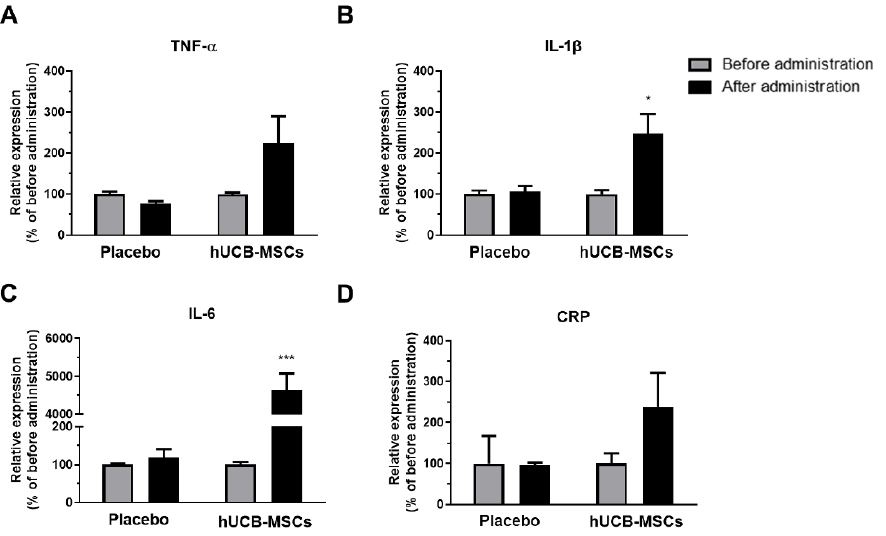
Figure 1. Pro-inflammatory cytokine levels increased in AD patients following hUCB-MSCs injec- tion. Tumor necrosis factor- α ( TNF- α ), interleukin- 1β ( IL- 1β ), interleukin-6 (IL-6), and c-reactive protein (CRP) ELISA was carried out using CSF samples collected before and after administration of saline (placebo, n = 3) or hUCB-MSCs ( n = 6). ( A ) TNF- α, ( B ) IL- 1β, ( C ) IL-6, and ( D ) CRP expression levels increased after hUCB-MSCs administration. In the placebo group, there was no difference in expression of all four cytokines before and after administration (* p < 0.05, *** p < 0.0001). The data are presented as the mean ± S.E.M.